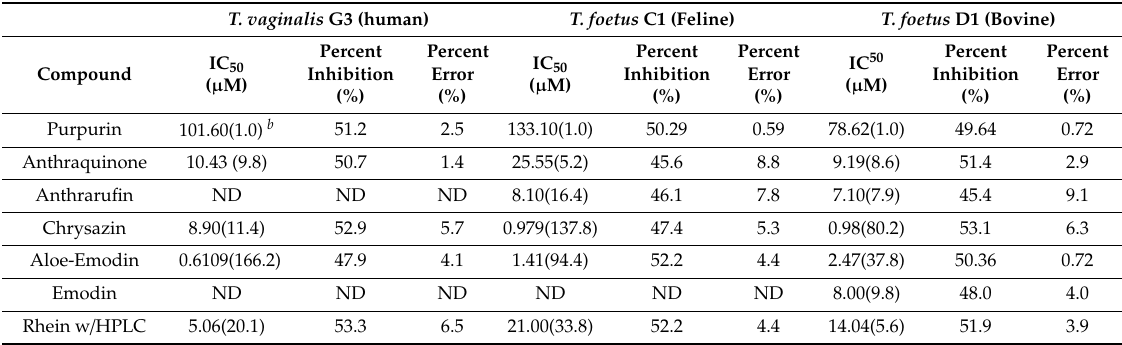
Table 1. Activity of anthraquinone and derivatives against pathogenic trichomonads. The table shows the calculated IC 50 for each anthraquinone and substituted derivative and its corresponding percent growth inhibition at the designated concentration a